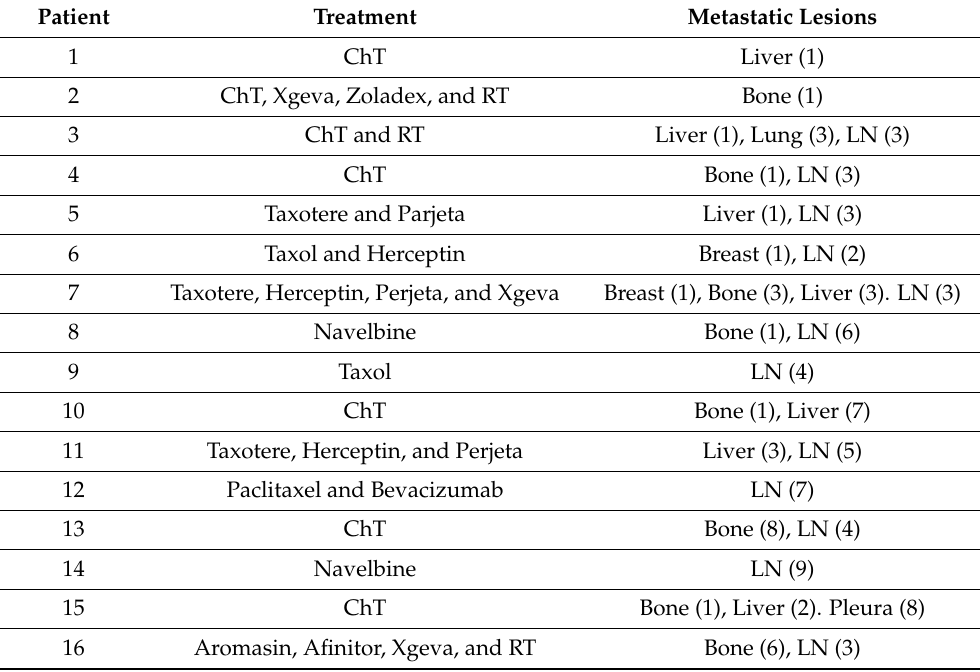
Table 3. Patients’ treatment and affectations’